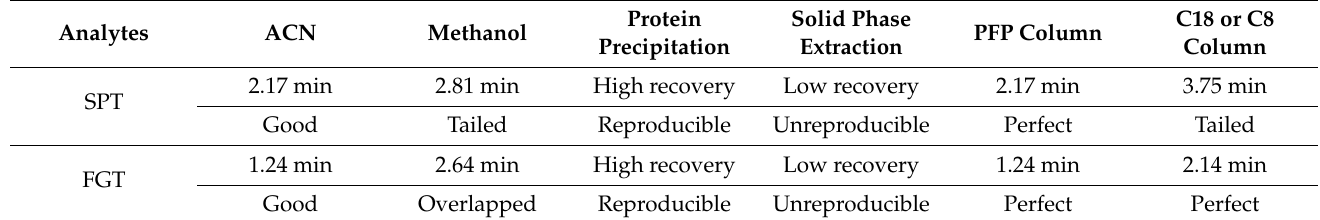
Table 1. Different experiments for separation of analyte